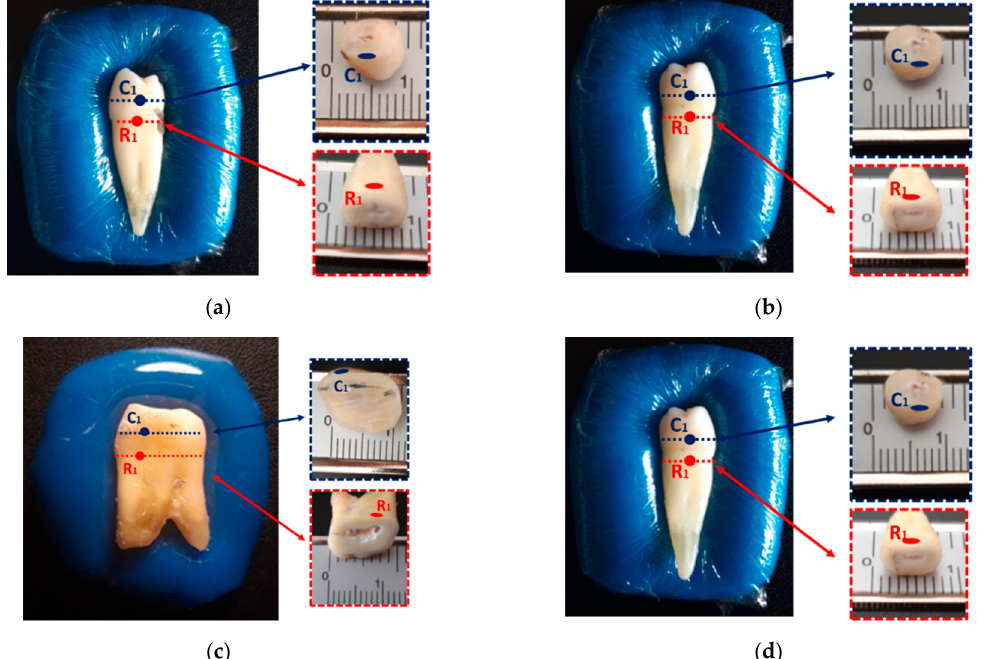
Figure 8. Illustration of the measurement locations on the crown (C1) and root (R1) of dental samples: ( a ) sample PM1; ( b ) sample PM2; ( c ) sample M1; ( d ) sample M2. At measuring sites, the crown and root wall thickness were approximately 2 mm. The pulp cavity of the crown and premolars root had a thickness of approximately 1 mm, while pulp cavity of the molar root measured 2 mm. The pulp cavity was partially filled with devitalized tissue. For the molar crown, the thickness of the pulp cavity was less than 0.5 mm.